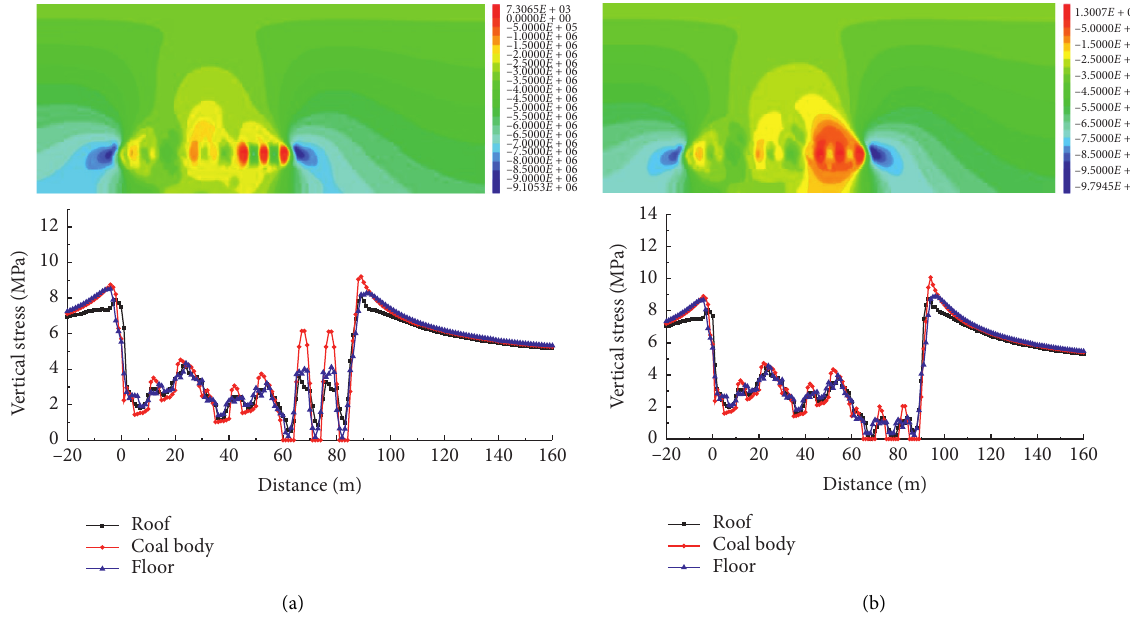
Figure 9: Filling and mining in the first group. (a) One-step mining stress contour and curve. (b) Two-step mining stress contour and curve.